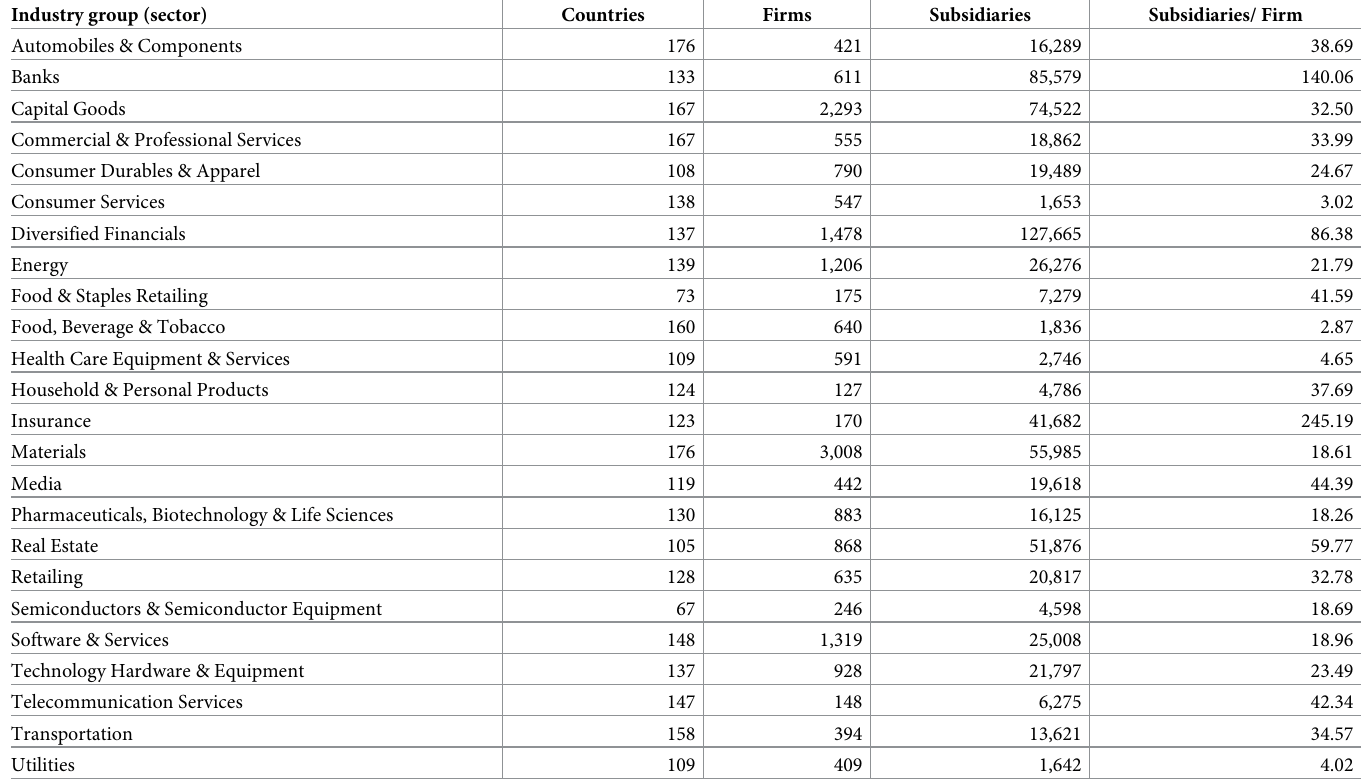
Table 1. GICS industry groups (sectors) by a number of countries, headquarters and subsidiaries in the network. Industry group